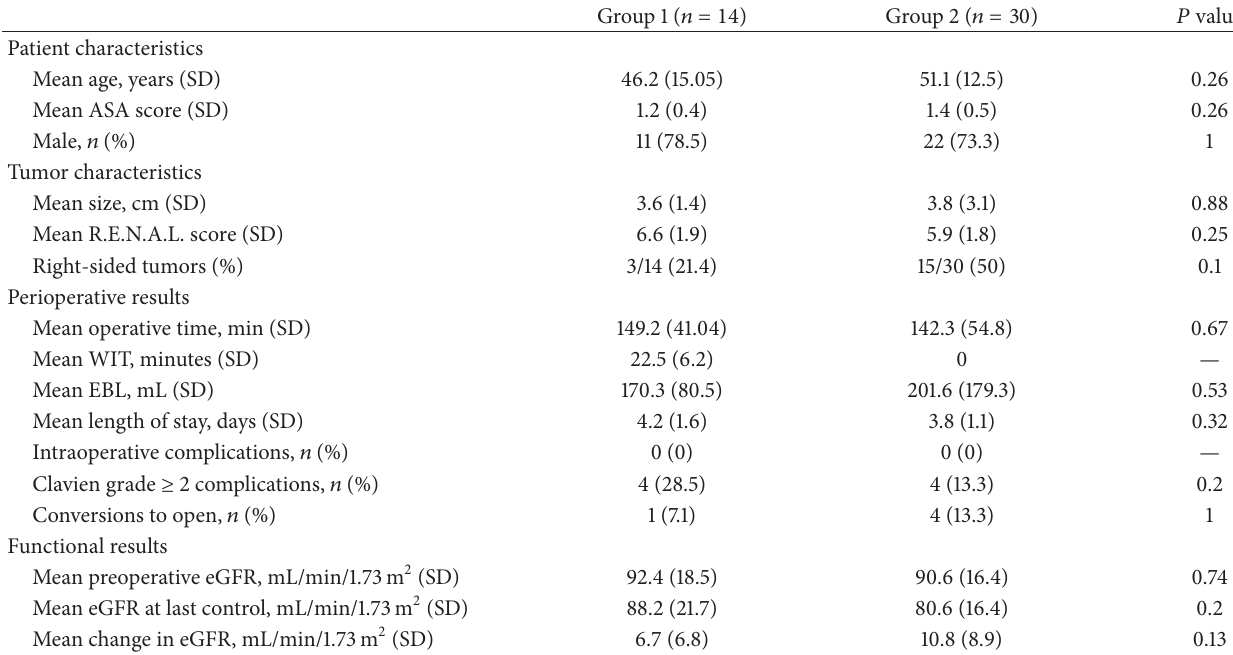
Table 1: Differences between group 1 and group 2 in terms of patient characteristics, tumor characteristics, perioperative results, and functional results.